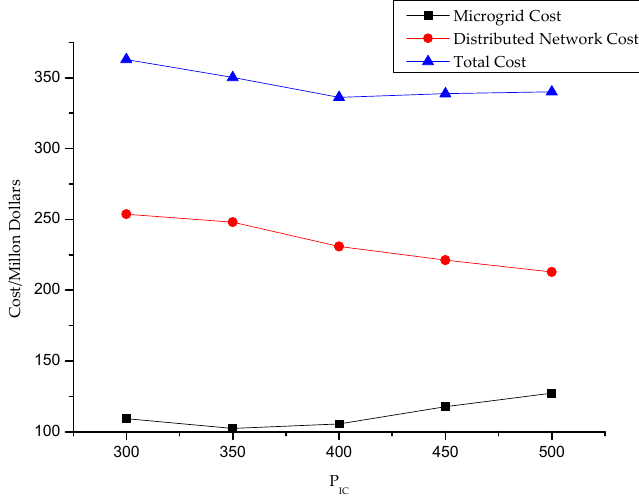
Figure 9. Cost changes under different P IC conditions.